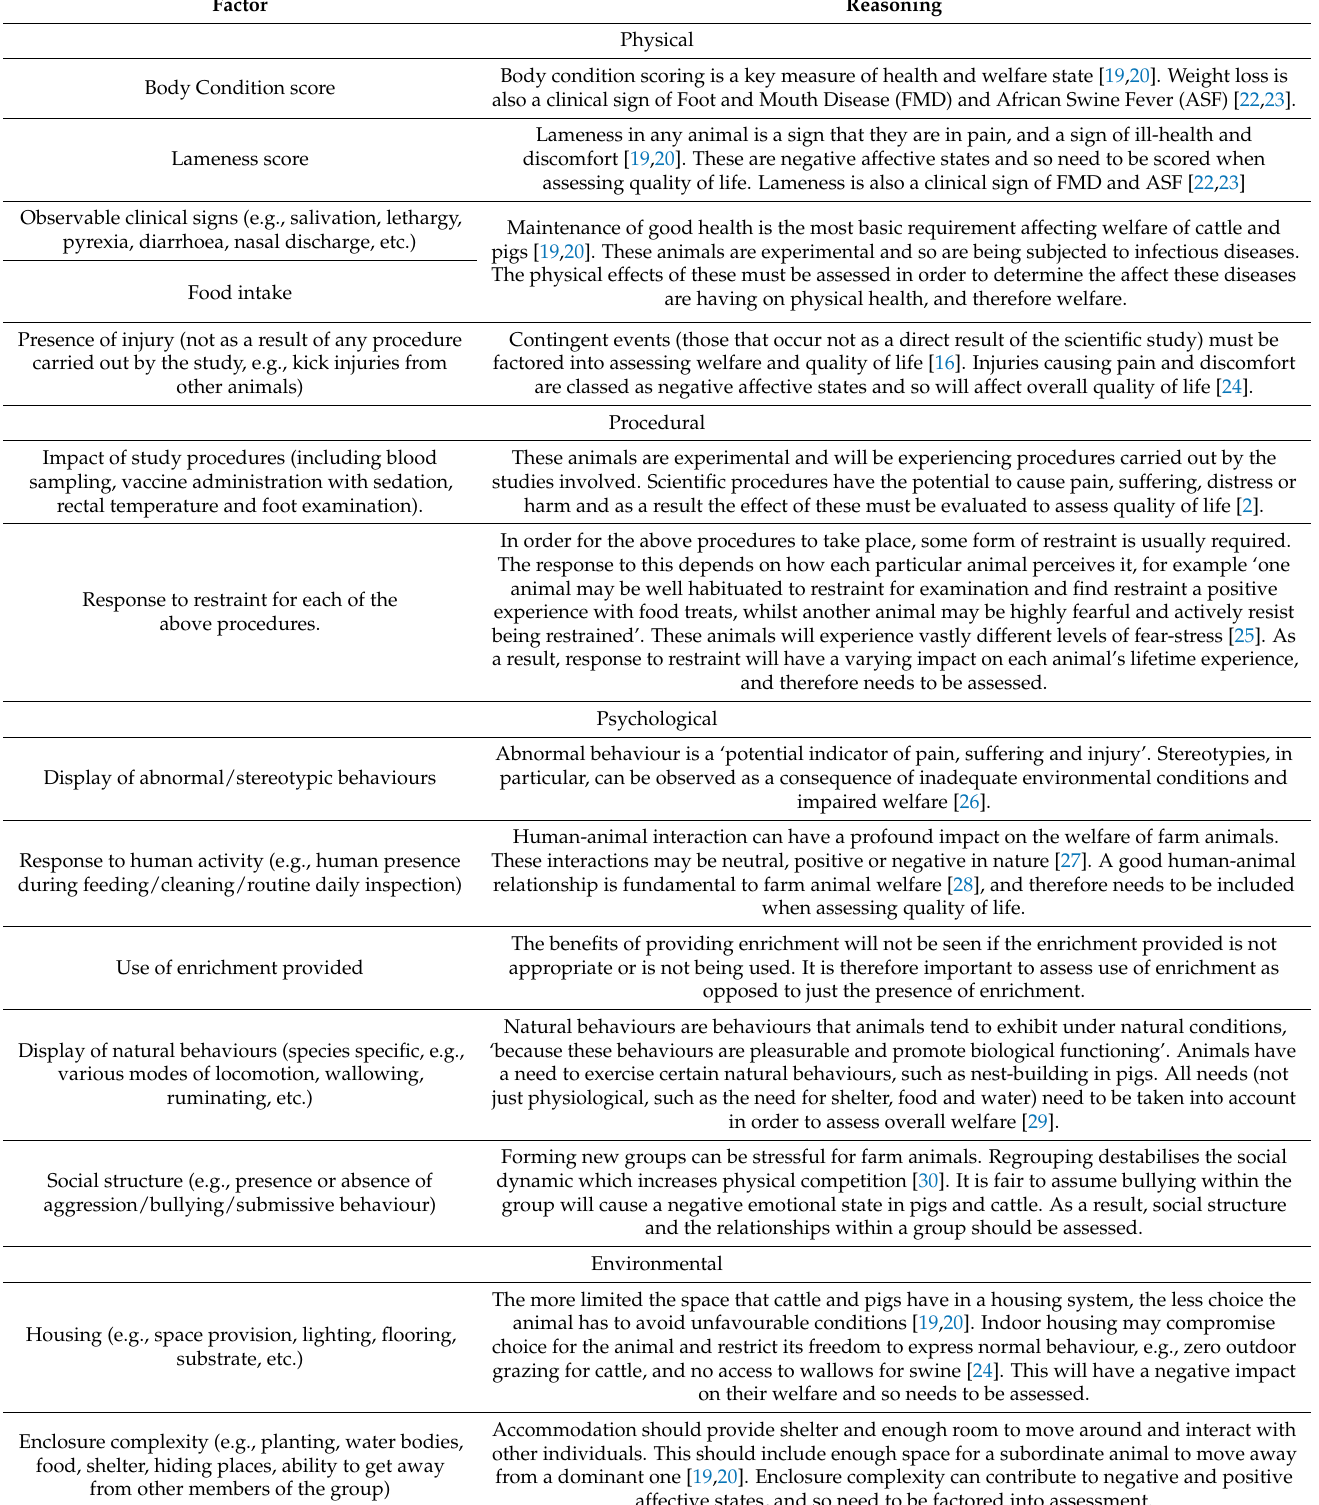
Table 1. Table showing the full list of factors selected for both cattle and pigs, as well as the reasoning for selection.